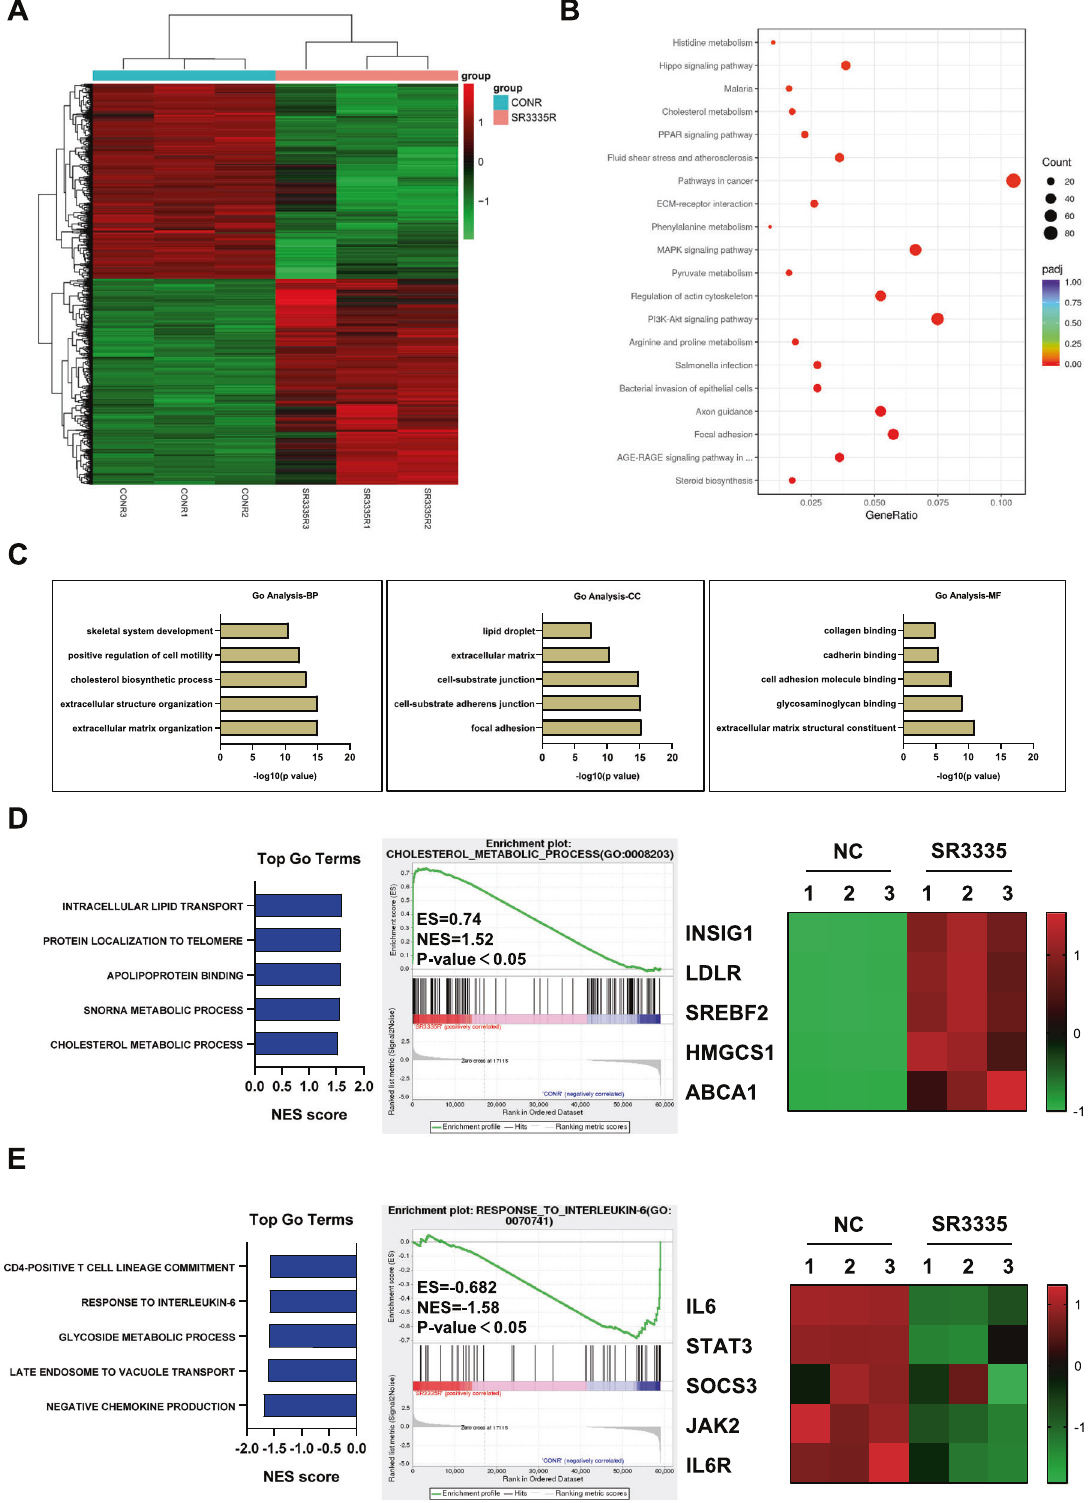
Fig. 4 ROR α affected the IL-6-related pathways. A The heatmap of DEGs, as detected by RNA-seq in human articular chondrocytes treated with either SR3335 (1 µM) or vehicle (DMSO) for 48 h ( n = 3 biological replicates). B KEGG and C GO terms with the most signi fi cant P values. BP biological process, CC cellular component, MF molecular function. D GSEA of positively associated GO terms with SR3335 treatment (left panel) and cholesterol metabolic hallmark genes in chondrocytes treated with ROR α antagonist compared with vehicle (middle and right panel). E GSEA of negatively associated GO terms with SR3335 treatment (left panel) and IL-6-associated genes in chondrocytes treated with SR3335 compared with vehicle (middle and right panel).